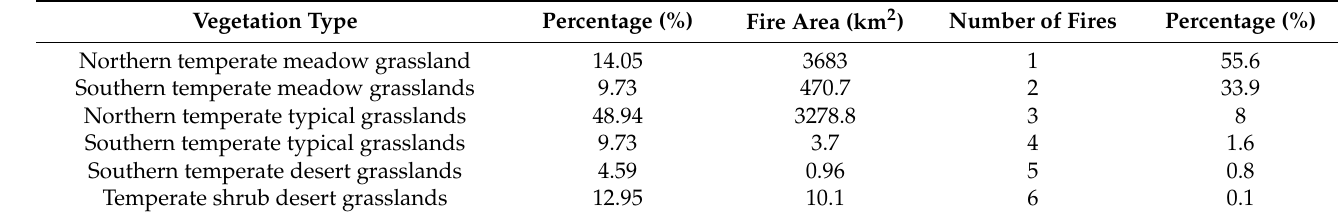
Table 1. Statistics of total fire area and number of fires from 2001 to